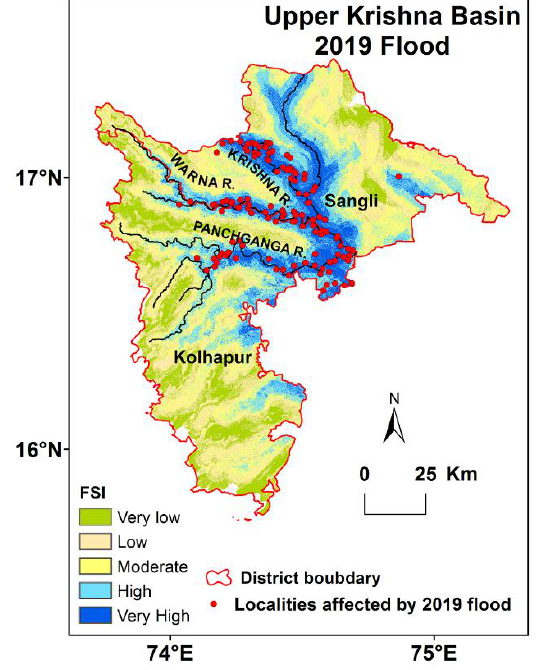
Figure 7. Severely flood-affected areas in Sangli and Kolhapur districts (August 2019).